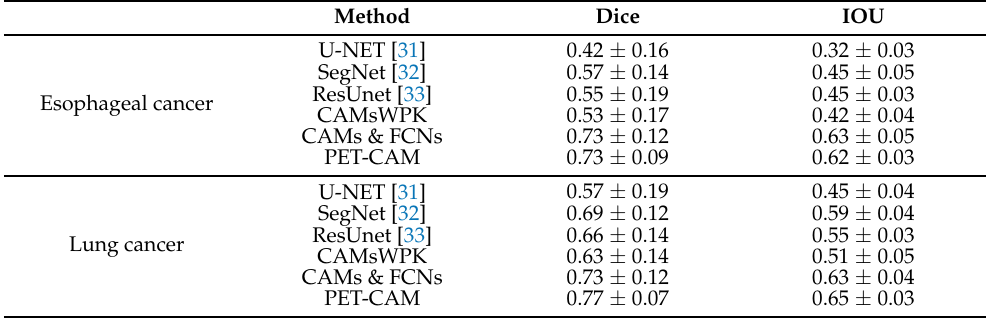
Table 1. Results for 3D segmentation. WPk: without prior knowledge. CAM: class activation